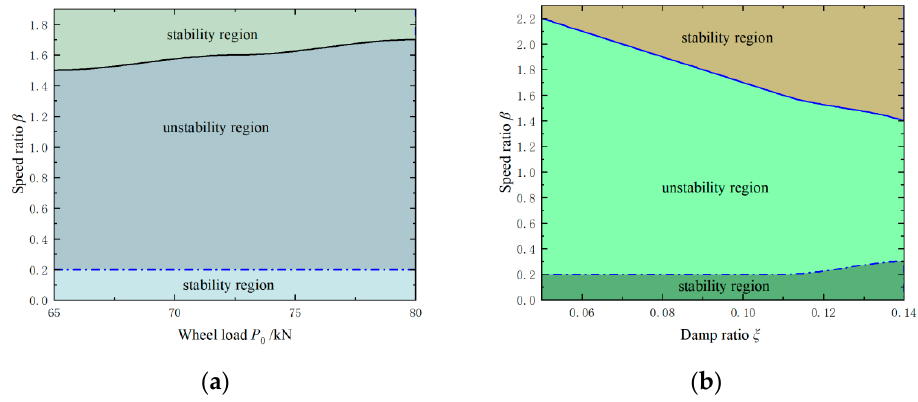
Figure 4. Critical curve between parameters β and P 0 , ξ : ( a ) P 0 – β critical curve; ( b ) ξ – β critical curve.